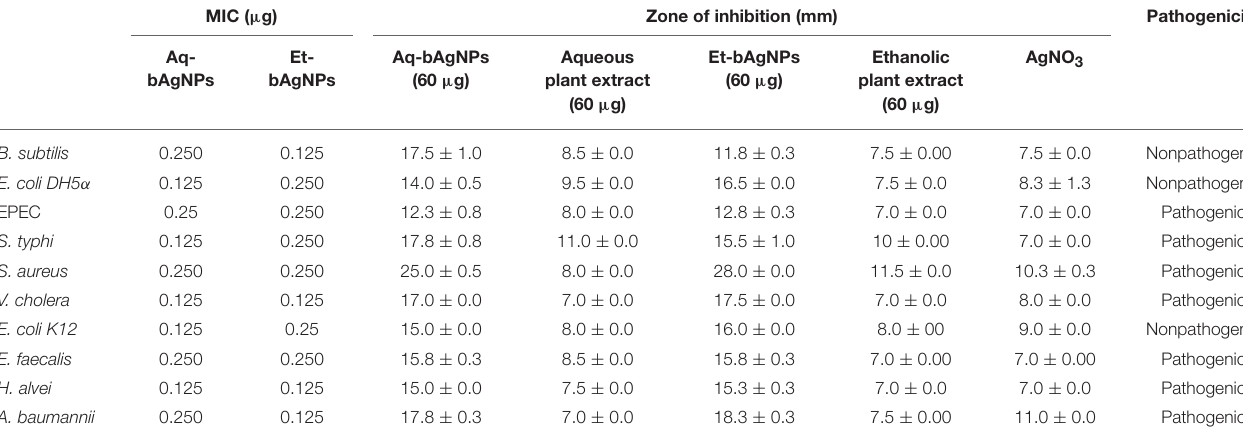
TABLE 1 | Zone of inhibition and MIC value for bAgNPs against